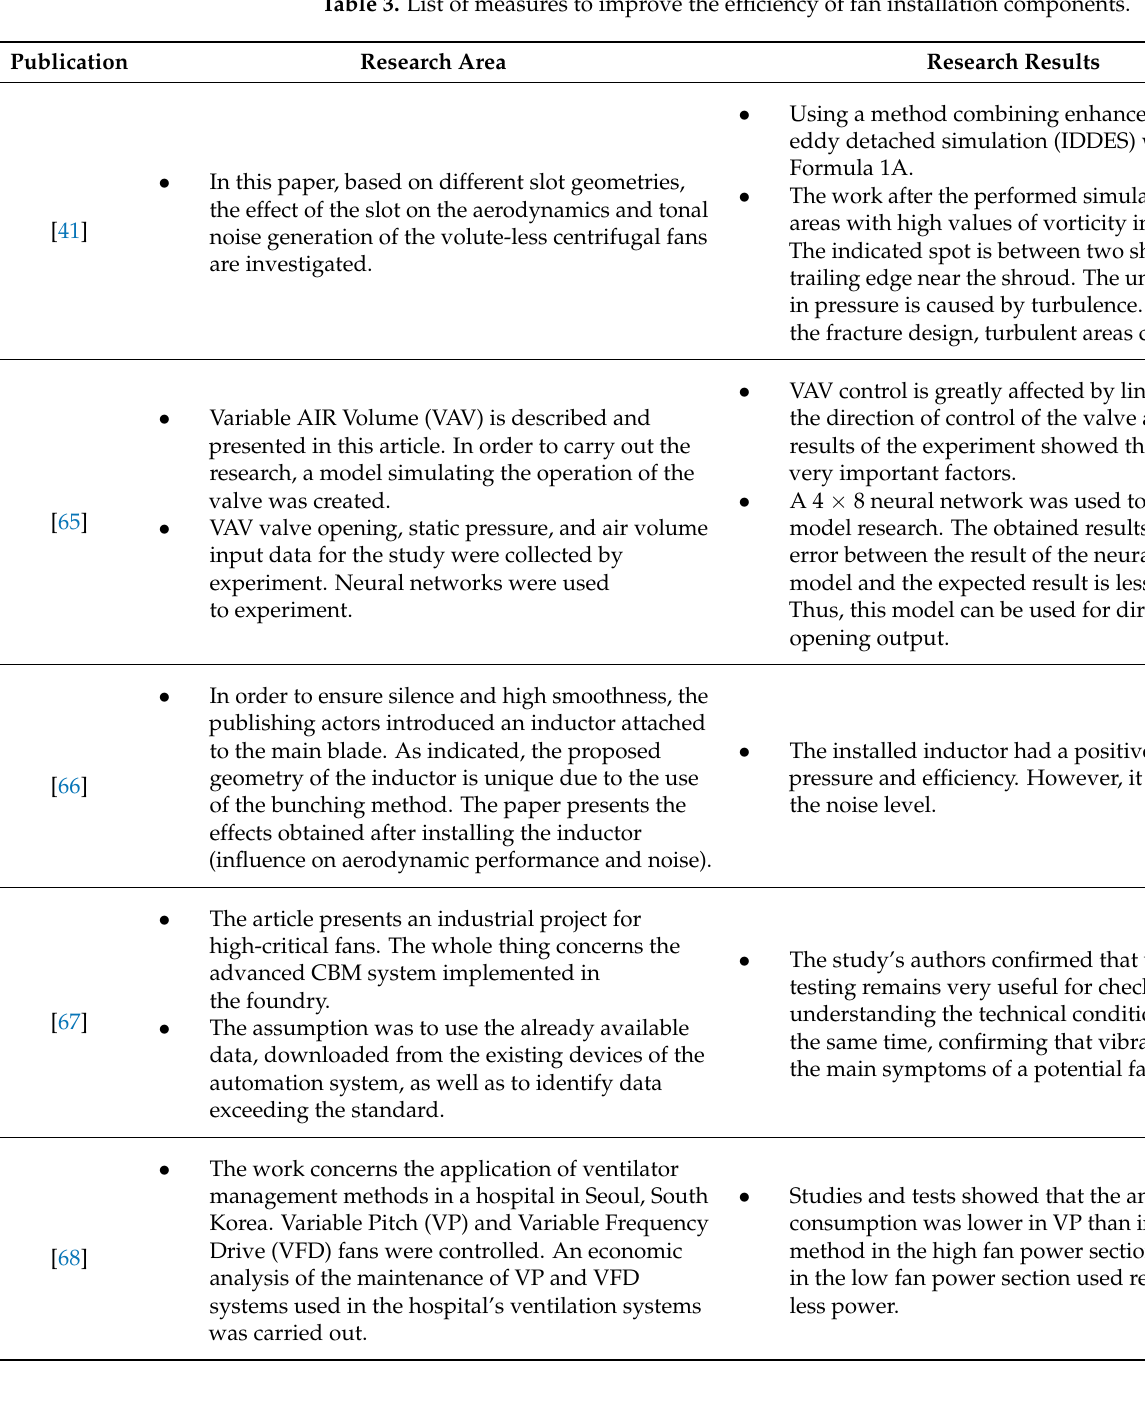
Table 3. List of measures to improve the efficiency of fan installation